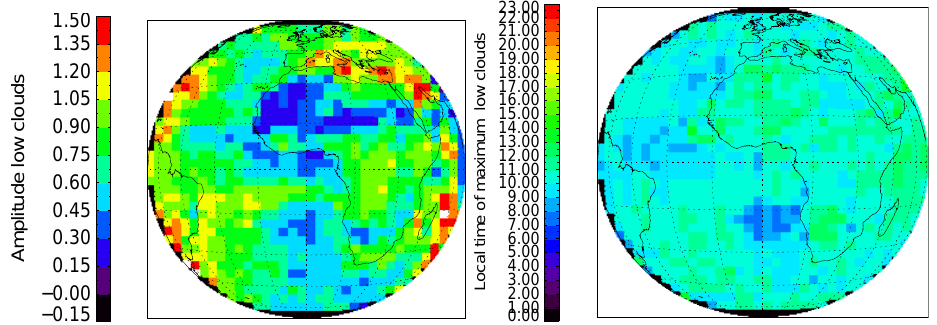
Fig. 11. Left: relative amplitude of the intrinsic LWP cycle of low clouds for April 2009. Right: local time of the maximum of low cloud LWP in the diurnal cycle for April 2009. One grid box contains 36 × 36 SEVIRI pixels, all LWP fields or April 2009 were averaged.